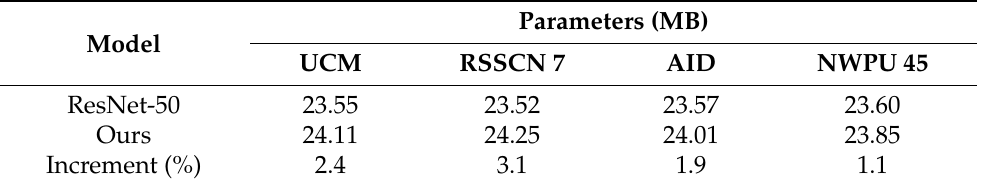
Table 1. Comparison of sizes of the models before and after improvement.